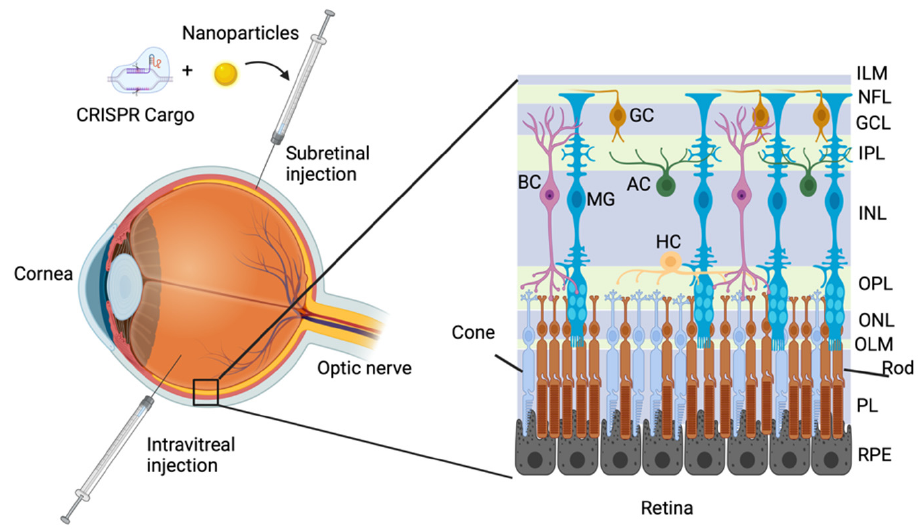
Figure 1. Delivery routes of CRISPR/Cas cargo to the mammalian retina. A representative illustration of the major delivery routes of CRISPR/Cas cargo to the retina represented by subretinal and intravitreal injections. The mammalian retina is divided into three main laminar layers: the outer nuclear layer (ONL), the inner nuclear layer (INL), and the ganglion cell layer (GCL). There are six different retinal neuronal cell types and one glial cell type distributed within the nuclear layers: the rod and cone photoreceptor nuclei are located in the ONL, whereas the nuclei of the bipolar (BC), horizontal (HC), amacrine (AC), and Müller (MG) cells are located in the INL. The cell bodies of the ganglion cells (GC) are located in the GCL. The processes of the different cells are extended into two plexiform layers. Processes from the photoreceptor cells are extended into the outer plexiform layer (OPL) to form synapses with the retinal neurons. Processes from the bipolar, horizontal, amacrine, as well as Müller cells are extended into the inner plexiform layer (IPL). The axons of the ganglion cells are directed into the optic nerve through the nerve fibre layer (NFL).